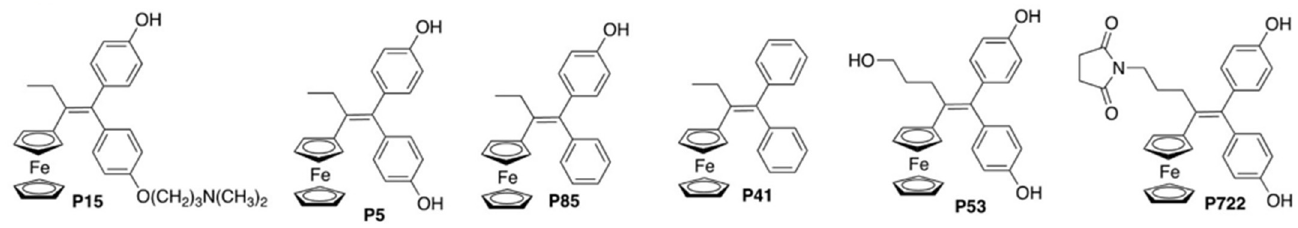
Figure 1. Structure of ferrocifens used in this study.